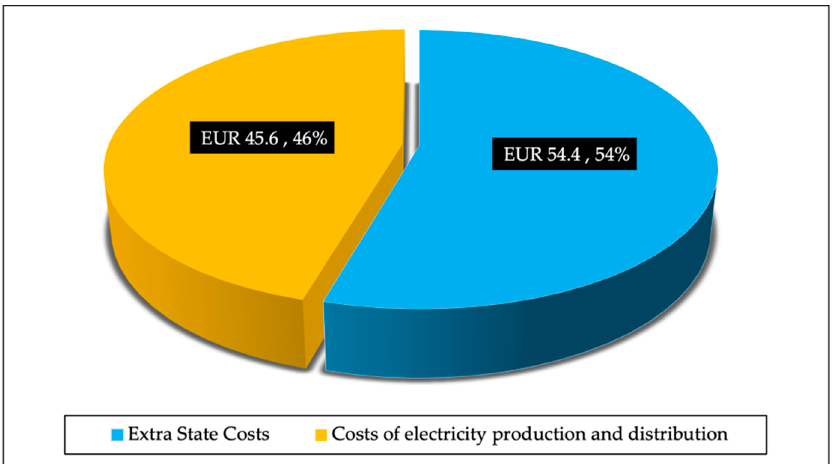
Figure 6. The percentage of the electricity bill corresponds to costs of production and distribution of electricity and extra costs of the Spanish State as of the middle of 2021. Source: Own elaboration from CNMC [95].